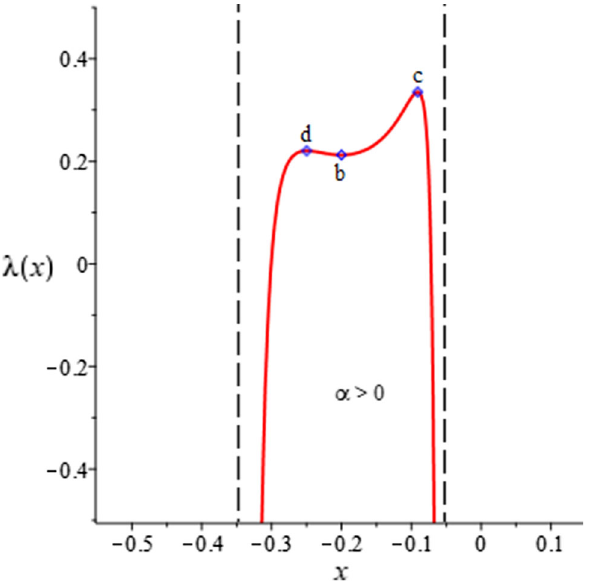
Fig. 5 The function (cid:2)( x ) = λ( x )/α for α = ± 1, l = 3